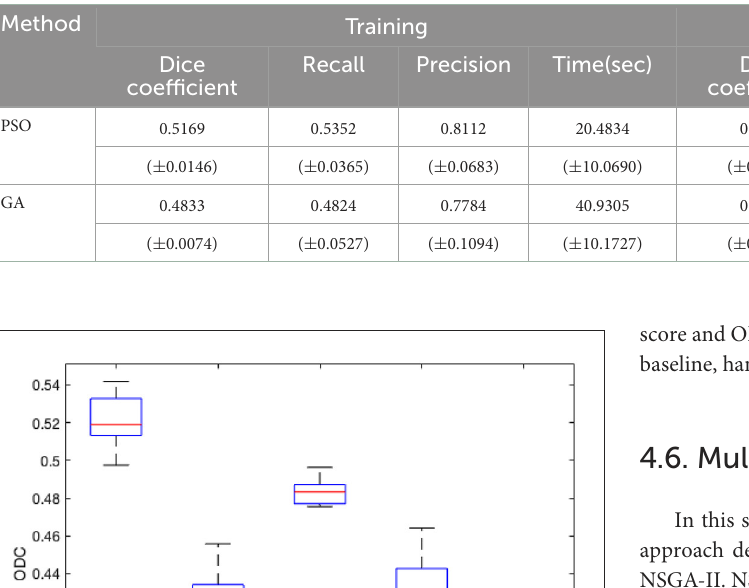
TABLE 7 Training and testing results for NEDECO-PSO-CellSort and NEDECO-GA-CellSort.